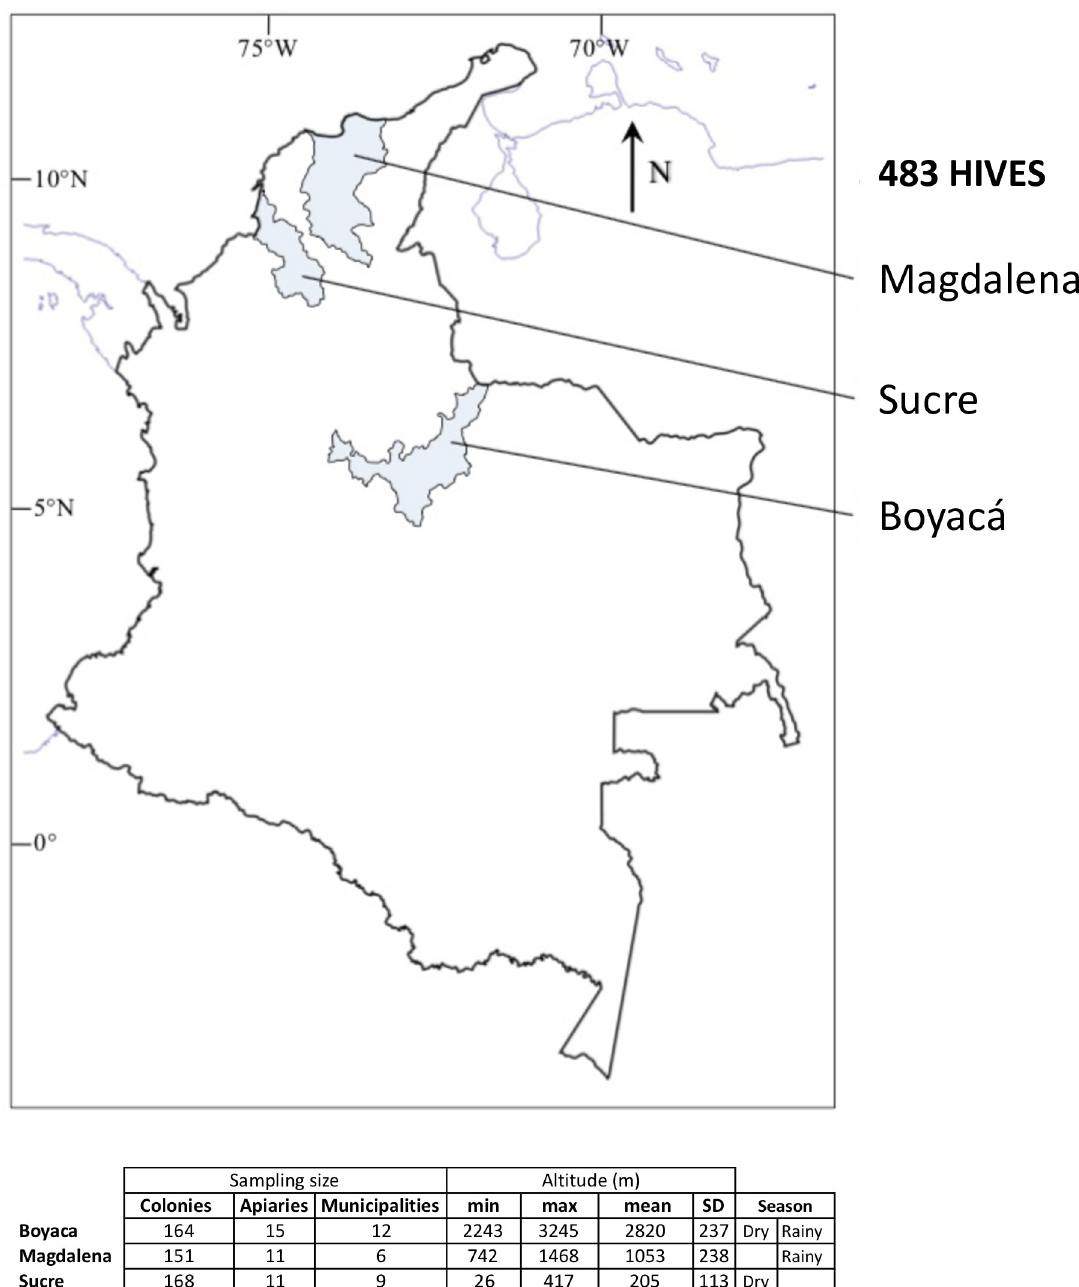
Fig 1. Map of Colombia showing the geographic localization of the three regions analyzed in this study (highlighted in blue) and the number of stationary colonies sampled in each region. Minimum (min), maximum (max), mean and standard deviation (SD) are indicated in meters